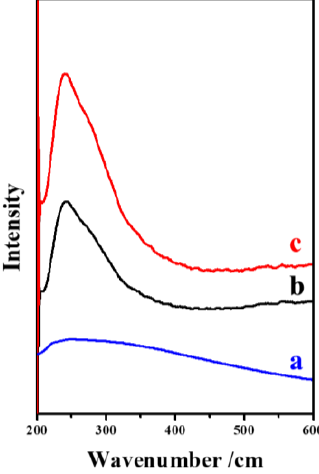
Figure 5. UV-Vis spectra of ( a ) RUB-37, ( b ) Sn-JHP-1 and ( c ) Sn-JHP-2.